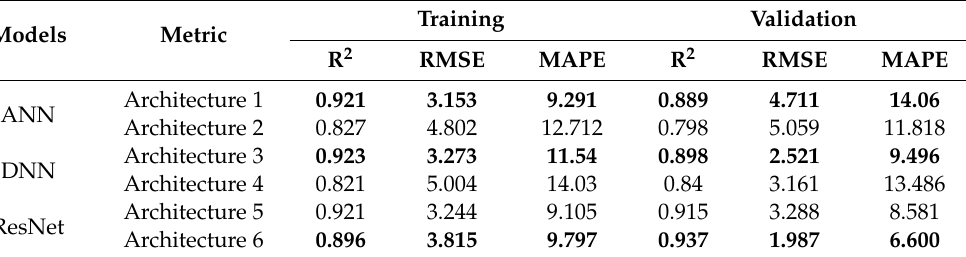
Table 4. Performance comparison of six architectures for FAGP compressive strength prediction